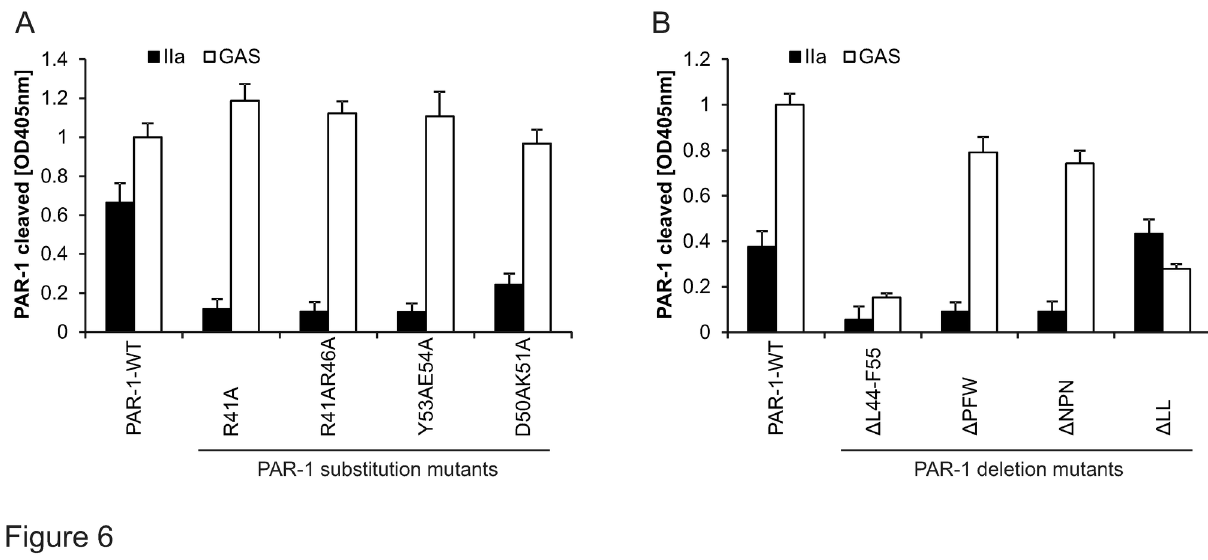
Figure 6. SpeB specifically cleaved endogenous PAR-1 at leucine analysed for their ability to cleave ( A ) variants of AP-PAR-1 with alanine substitutions at indicated positions and ( B ) mutants of AP- PAR-1 with deletions at indicated positions. Experiments were repeated at least 3 times with N=9 per point, data presented as mean +/-